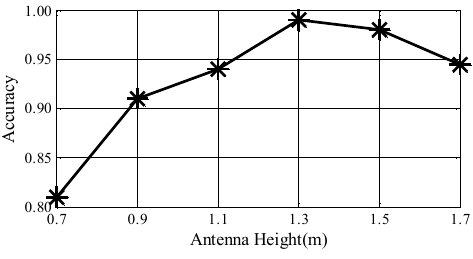
Figure 14. Impact of antenna height.